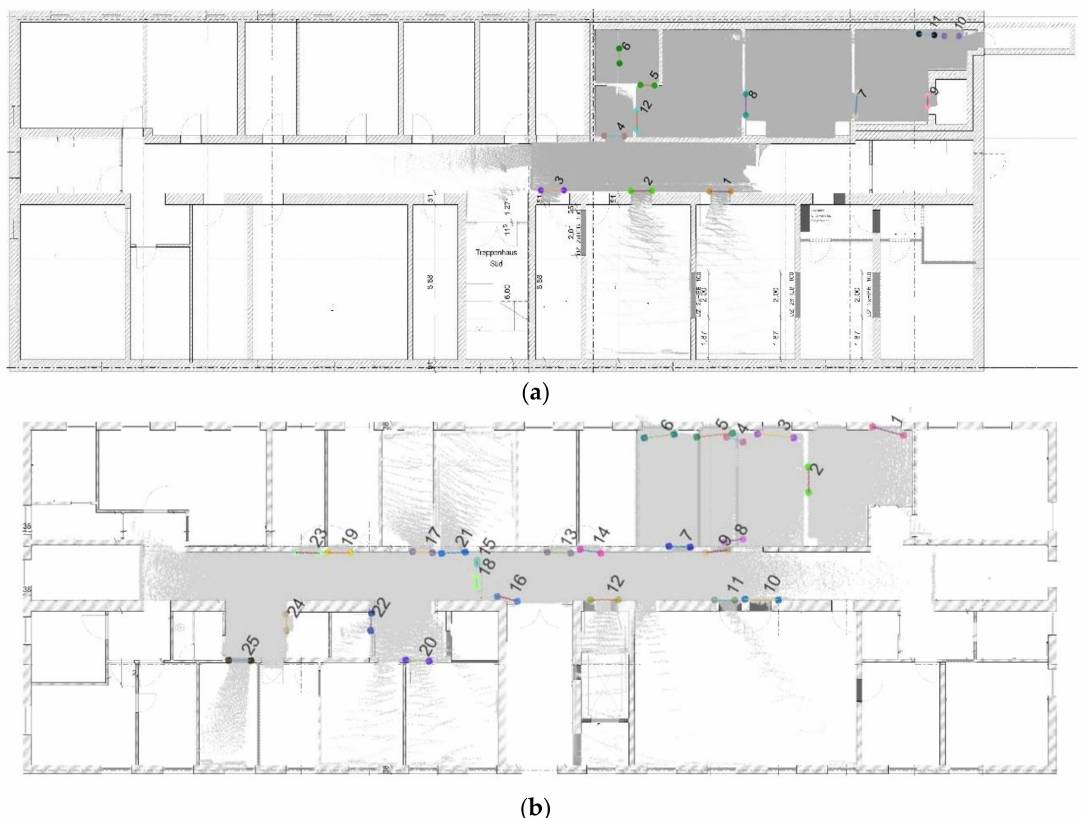
Figure 18. Visual comparison of the opening extraction results and ground plan ( a ) extracted openings in dataset 1; and ( b ) extracted doors in dataset 2 (opening segments are shown in different